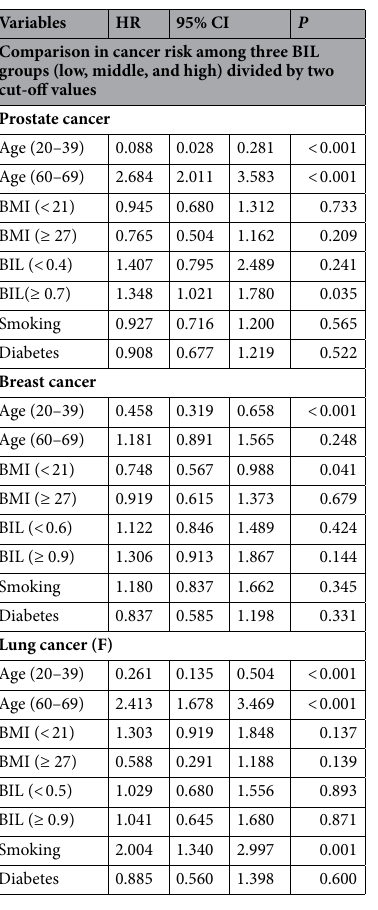
Table 3. The associations between serum bilirubin levels and each cancer risk (prostate, breast, and lung cancer in women). For prostate cancer, breast cancer, and lung cancer in women, serum bilirubin levels were divided into three groups by the two cut-off values. BIL (< 0.4, 0.5, or 0.6), subjects with bilirubin levels < 0.4, 0.5, or 0.6 mg/dL; BIL (≥ 0.7 or 0.9); subjects with bilirubin levels ≥ 0.7, or 0.9. The reference group for serum bilirubin levels was a middle range group. Age (20–39), subjects aged 20–39 years old; Age (60–69), subjects aged 60–69 years old; BMI (< 21), subjects with body mass index < 21 kg/m 2 ; BMI (≥ 27), subjects with body mass index ≥ 27 kg/m 2 . The reference of age and BMI was a middle range